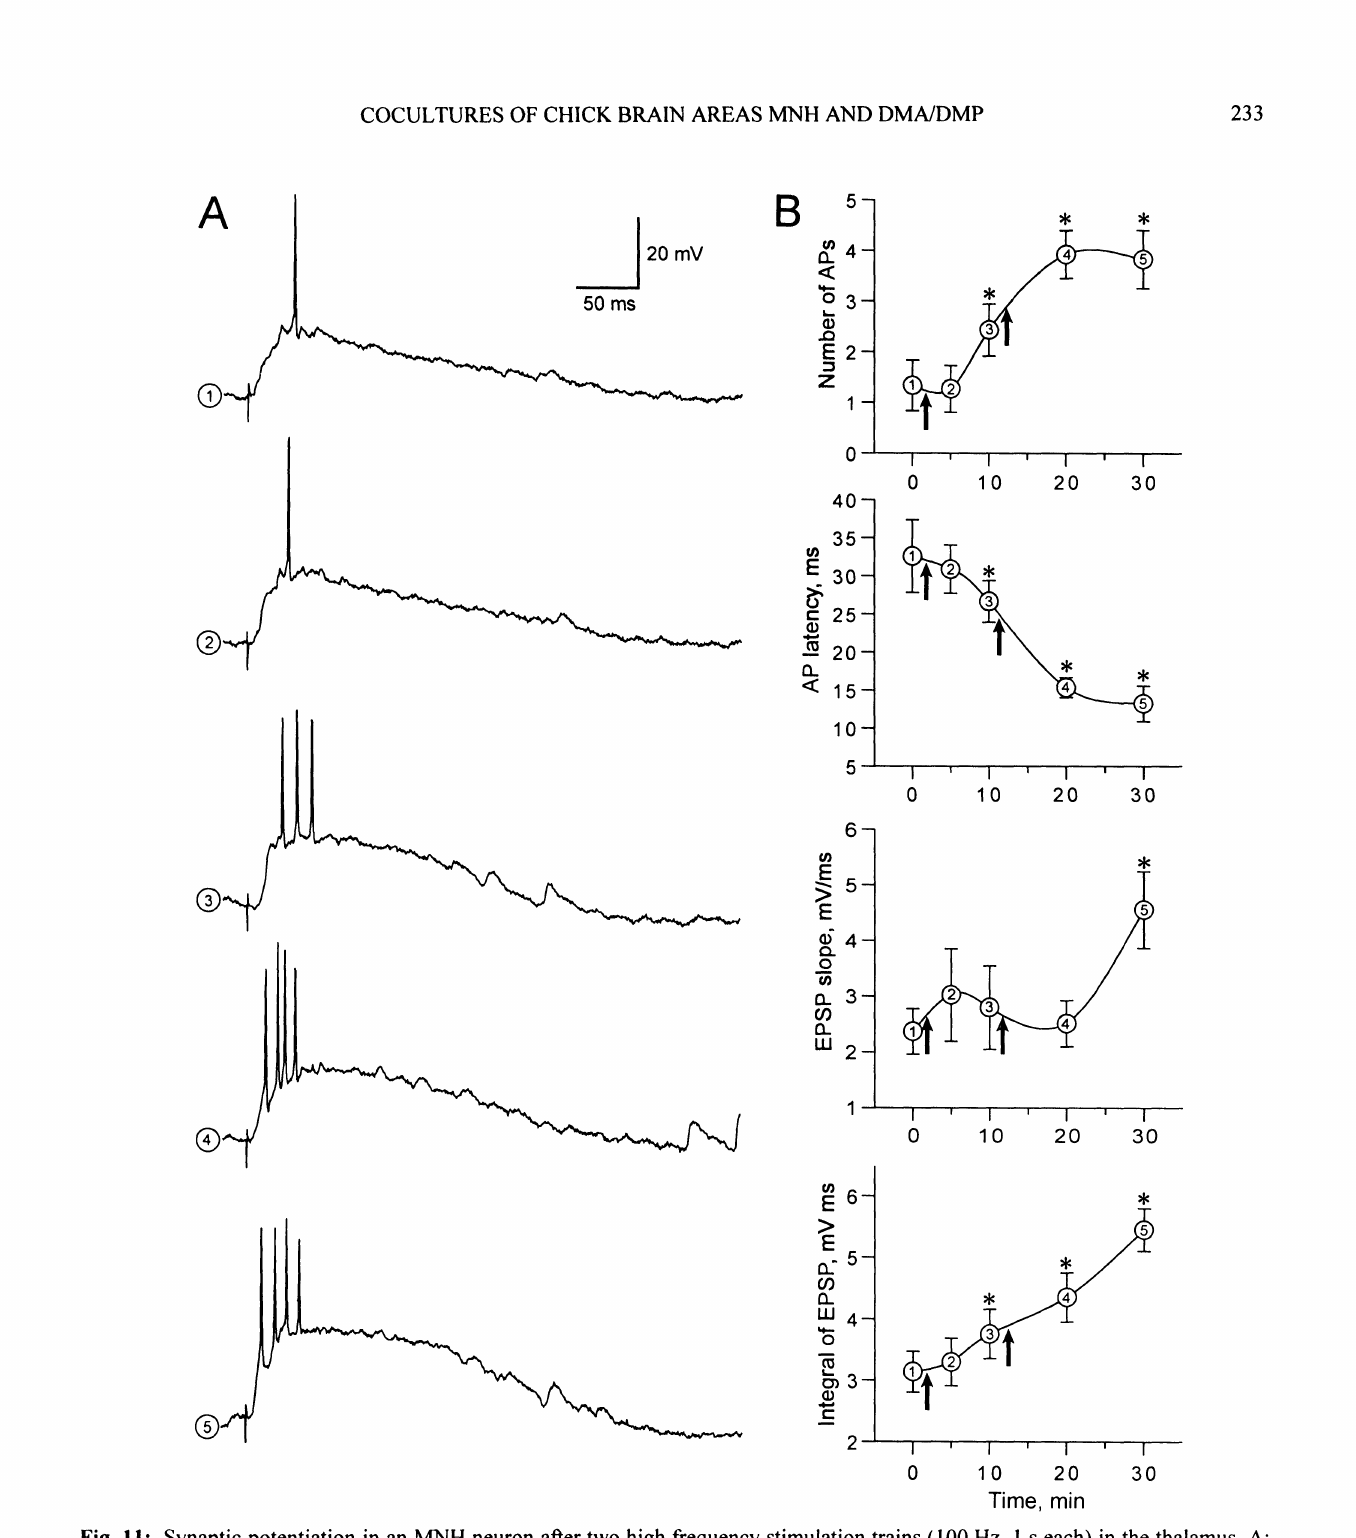
Fig. I: Synaptic potentiation in an MNH neuron after two high frequency stimulation trains (100 Hz, s each) in the thalamus. A: Response to single thalamus stimulation; (R) control recording, (R) 4 min after first high frequency stimulation, (R) 9 min after first high frequency stimulation, (R) 9 min after second high frequency stimulation, (R) 19 min alter second high frequency stimulation. B: Mean values + standard deviation of response parameters calculated out of 25 recordings each. Arrows indicate high frequency stimulation in the thalamus. Significant differences from (R) (p<0.05) are indicated by